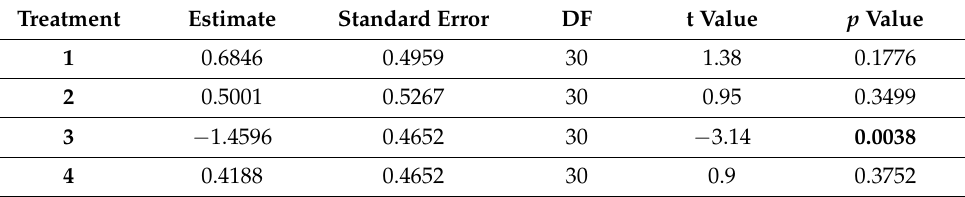
Table 3. Least squares means produced by the mixed procedure for the scores of PC7 extracted from long-term VN-FD spectral average dataset and that revealed a significant treatment effect. This table shows that TR3 scores were significantly different from the other treatments (bolded). DF = degrees of freedom. Treatment Estimate